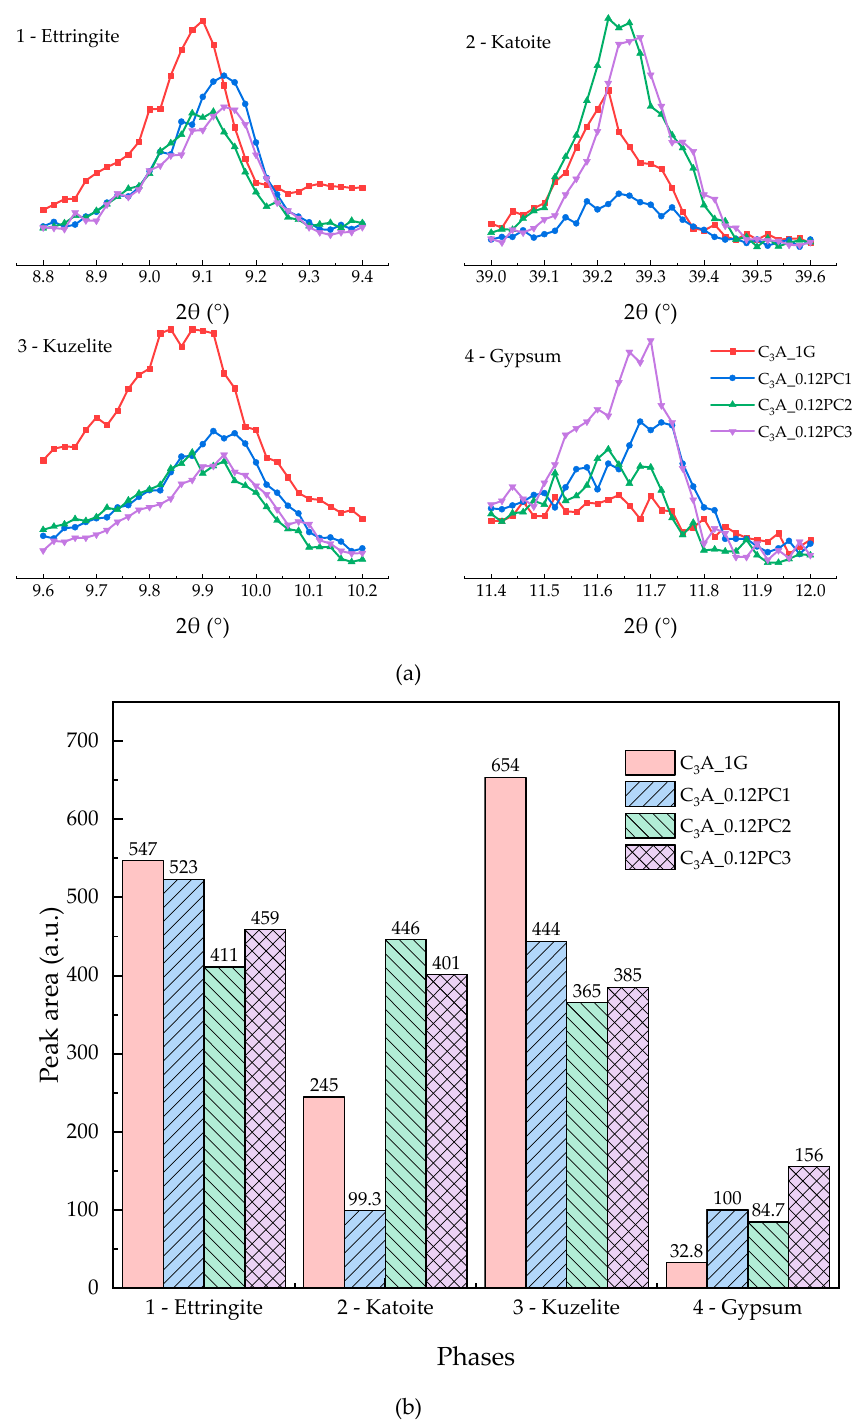
Figure 11. ( a ) XRD patterns of phases obtained from C 3 A-gypsum with the same concentrations of different kinds of PCs solution after the 24-h hydration. ( b ) XRD peak area of each phase in (a).